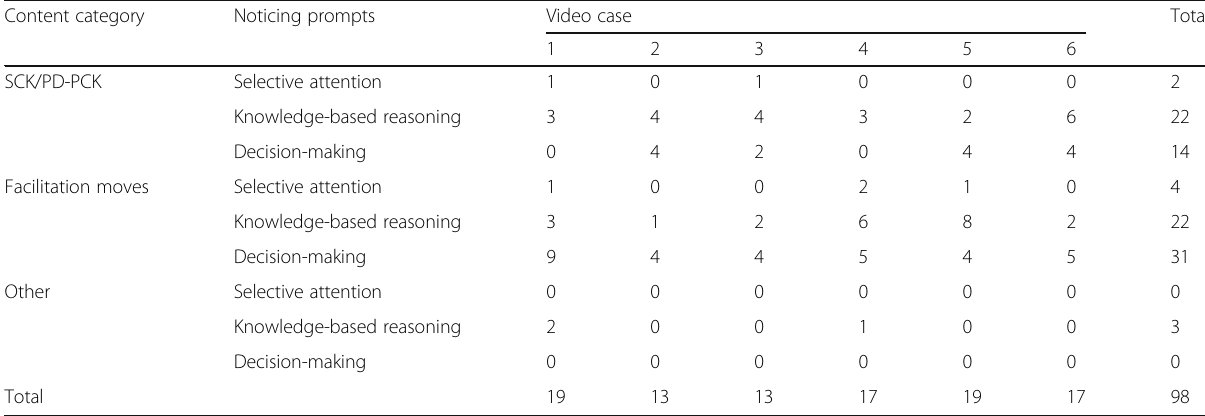
Table 8 Distribution of suggested prompts to the content and noticing categories per video case Content category Noticing prompts